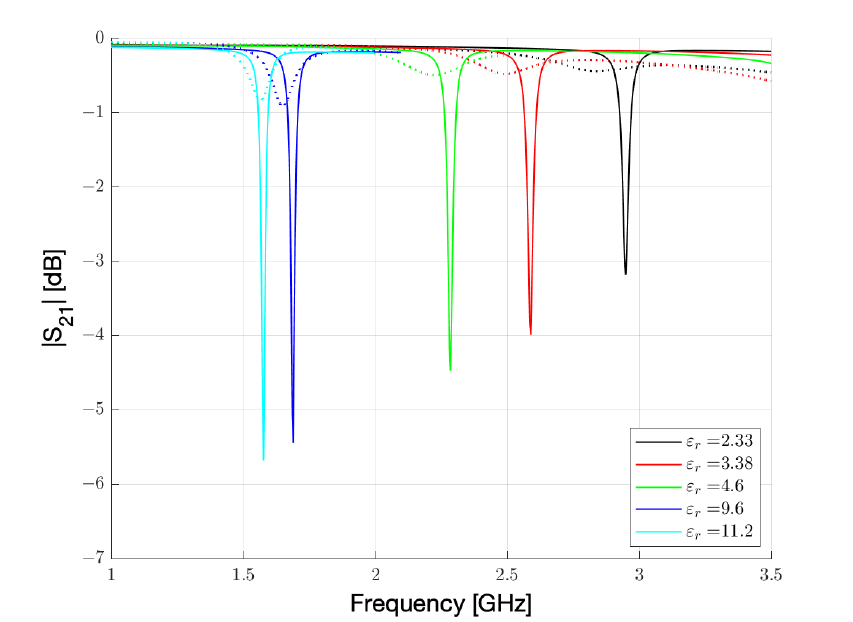
Figure 5. Simulated | S 21 | spectrum of the resonator reported in Figure 1 for the five substrates reported in Table 2. Continuous lines represent γ = 1 results. Dashed lines represent γ = 3